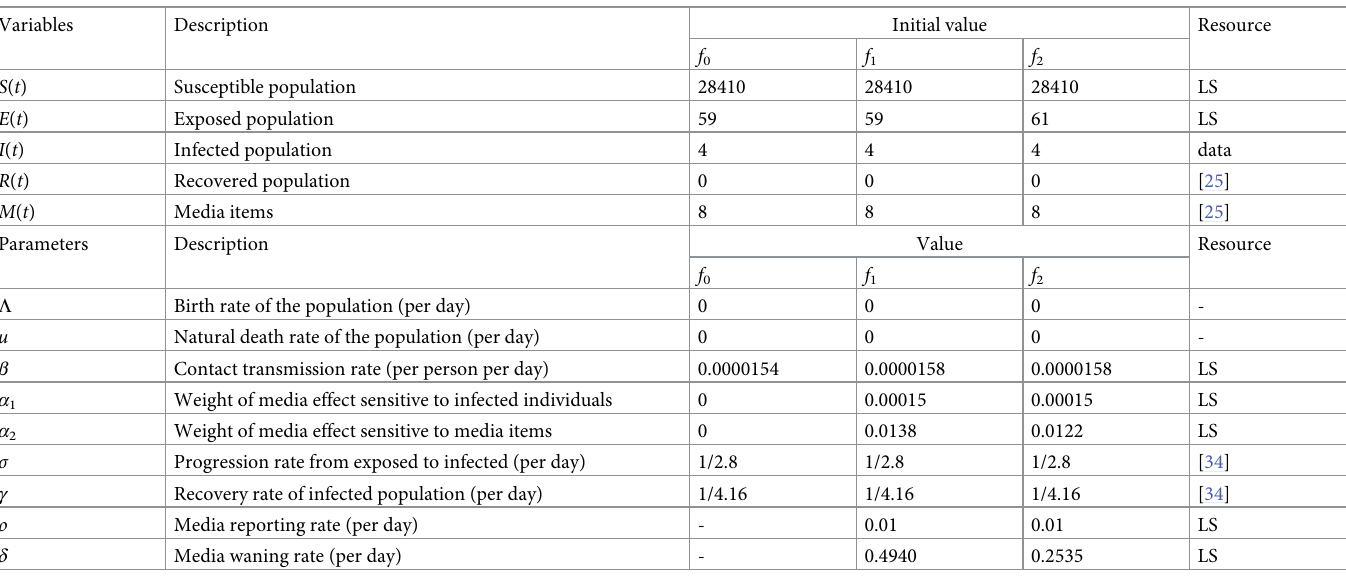
Table 1. Values of initial populations and parameters in the model